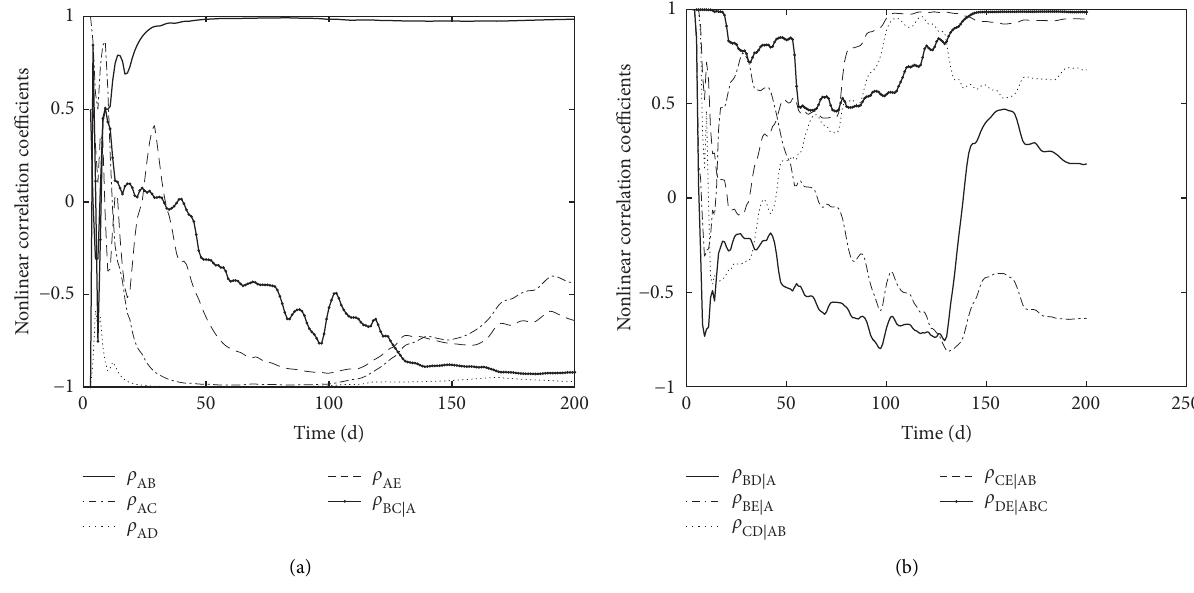
Figure 10: Time-dependent nonlinear correlation coefficients.